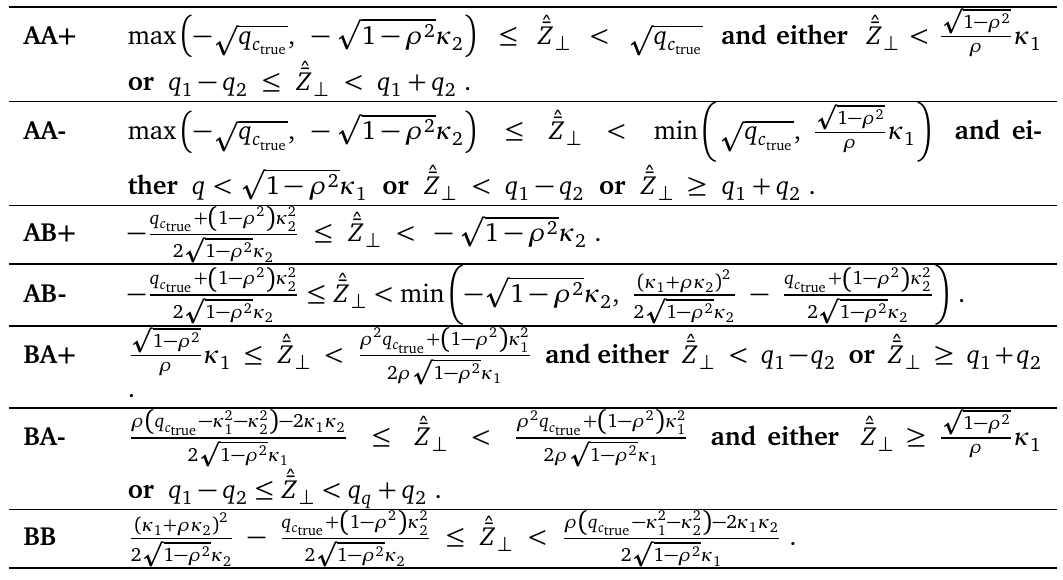
Table 1: Conditions defining when each class contributes to p AA + max